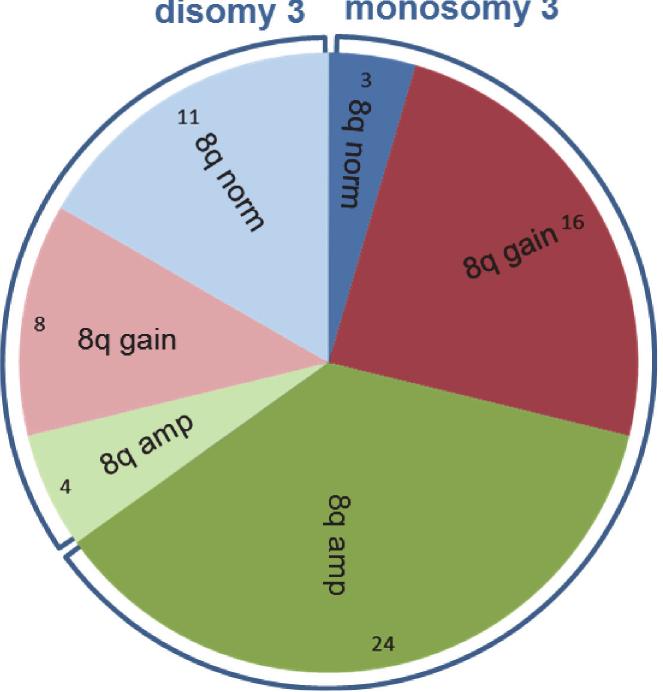
Fig 5. Non-random distribution of monosomy 3 and chromosome 8 aberrations. In 40 (61%) of the 66 UM monosomy 3 and 8q aberrations occur together. Non-random distribution is even stronger for 8q amplification and monosomy 3, as monosomy 3 is present in 24 (86%) of 28 UM with 8q amplification.